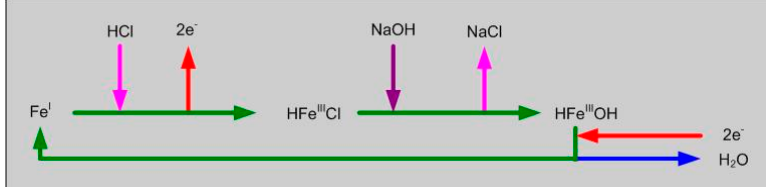
Figure 16. Catalytic ZVI desalination model [17]. The number of electrons transferred is a function of the oxidation number of the reduced state and the oxidized state. The potential range is from Fe 0 to Fe VIII . CO 2 + H 2 O + Cl − = HCO 3 − + HCl [16,17]; 0.5O 2 + 2Na + + H 2 O + 2e − = 2NaOH [16,17]. NaOH = NaO − + H + [16,17]. Fe III can reduce to Fe 0 . Fe III can reduce to Fe II . Fe can oxidize